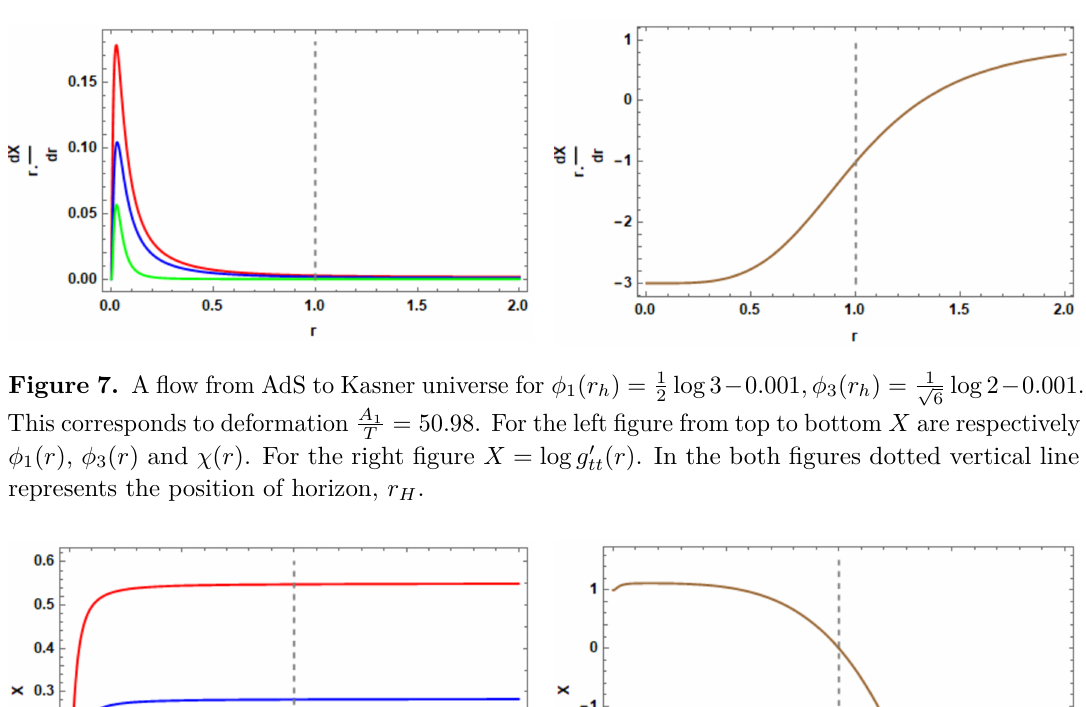
Figure 8. Behaviour of fields and metric functions for the flow of figure 7. In the left figure from top to bottom X are respectively φ 1 ( r ) , φ 3 ( r ) and χ ( r ) . For the right figure X = f ( r ) . In the both figures dotted vertical line represents the position of horizon, r H